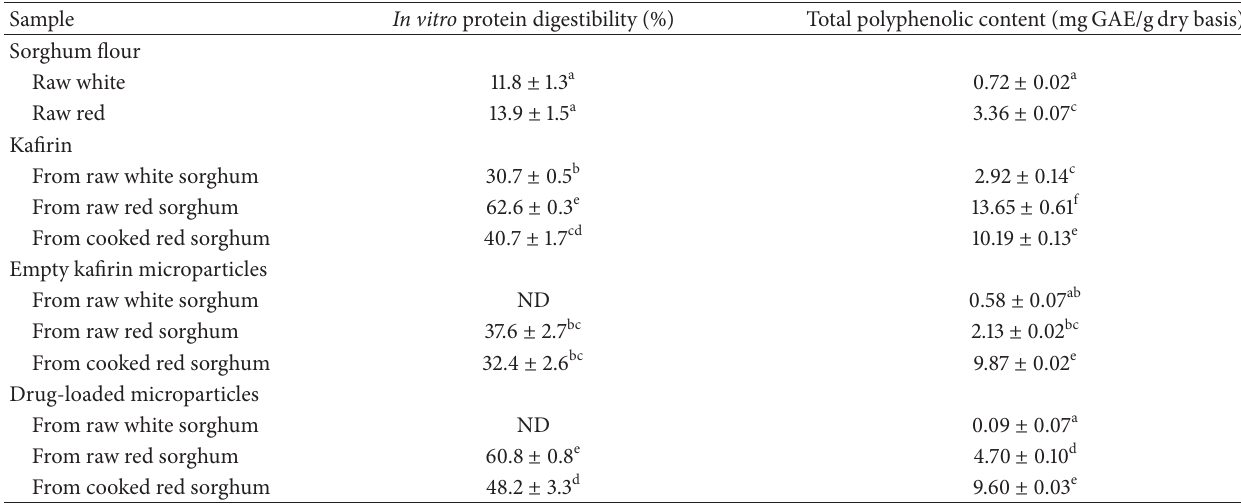
Table 1: In vitro protein digestibility and total polyphenolic content of wholegrain flours, isolated kafirins, and empty and drug-loaded kafirin